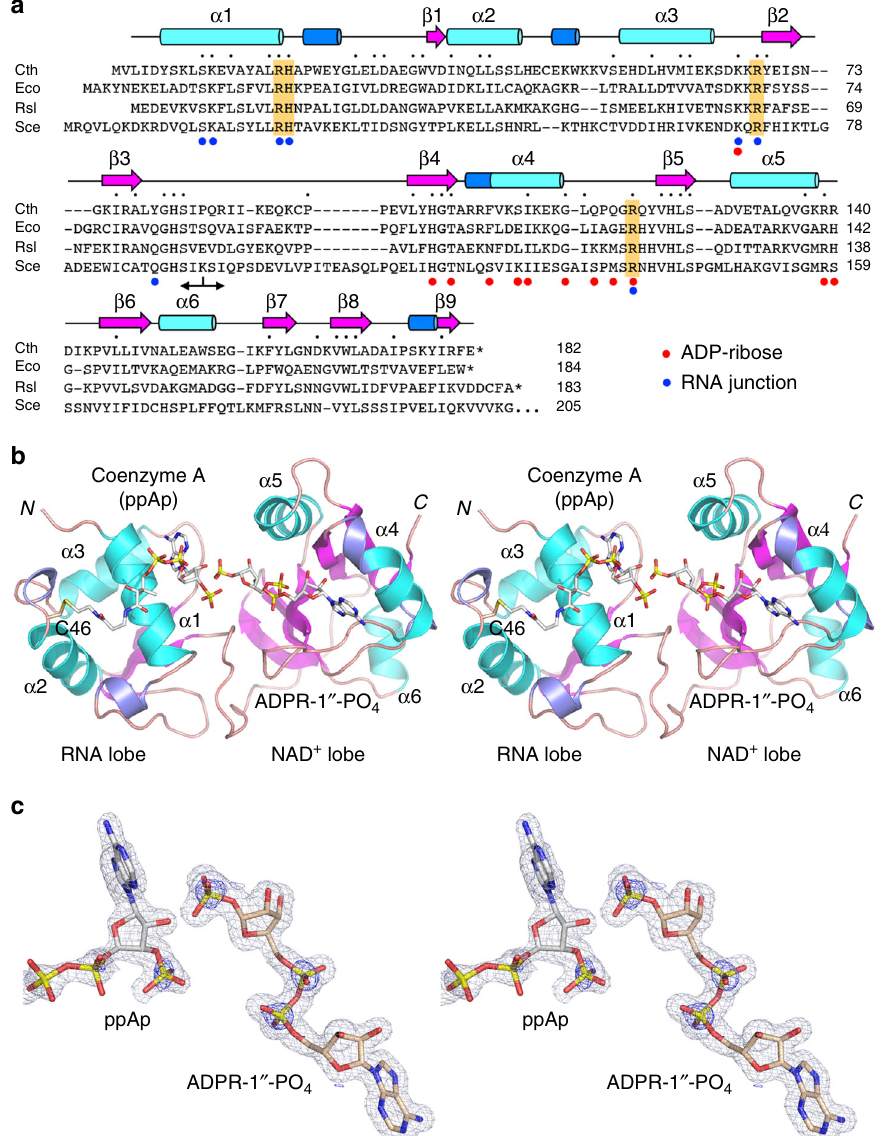
Fig. 2 Overview of the Tpt1 structure and active site ligands. a The primary structure of CthTpt1 is aligned to those of Tpt1 enzymes from Escherichia coli (Eco), Runella slithyformis (Rsl), and Saccharomyces cerevisiae (Sce). Positions of amino acid side chain identity or similarity in all four proteins are indicated by black dots above the CthTpt1 sequence. Gaps in the alignment are indicated by dashes. The constituents of a conserved Arg-His-Arg-Arg tetrad essential for Tpt1 activity are highlighted in gold shading. The secondary structure elements of CthTpt1 — magenta β strands, cyan α helices, and blue 3 10 helices — are displayed above the CthTpt1 sequence. The boundary between the N-terminal RNA lobe (aa 1 – 85) and the C-terminal NAD + lobe (aa 86 – 182) is demarcated by a two-headed arrow below the alignment. Amino acids that contact the ADP-ribose moiety in the NAD + site are denoted by red dots below the alignment. Amino acids that contact the RNA splice junction (the pAp and the 1 ″ -PO 4 ) are denoted by blue dots. b Stereo view of the CthTpt1 tertiary structure, depicted as a cartoon model with magenta β strands, cyan α helices, and blue 3 10 helices. The N and C termini are indicated and the α helices are numbered. The ADP-ribose-1 ″ -PO 4 and coenzyme A ligands are rendered as a stick models with gray carbons. c A stereo view of the simulated annealing omit 2Fo-Fc map of the ADP-ribose-1 ″ -PO 4 and pAp ligands in the active site, contoured at 1 σ , is shown in gray mesh. Anomalous difference density for the phosphorus atoms of ADP-ribose-1 ″ -PO 4 and pAp, contoured at 3 σ , is shown in blue mesh. The simulated annealing omit 2Fo-Fc and anomalous difference density maps were calculated with both ligands omitted from the model. Anomalous peaks for the sulfur atoms of Met60 and Cys94 were apparent at 4 σ but are not shown because they are remote from the two active site